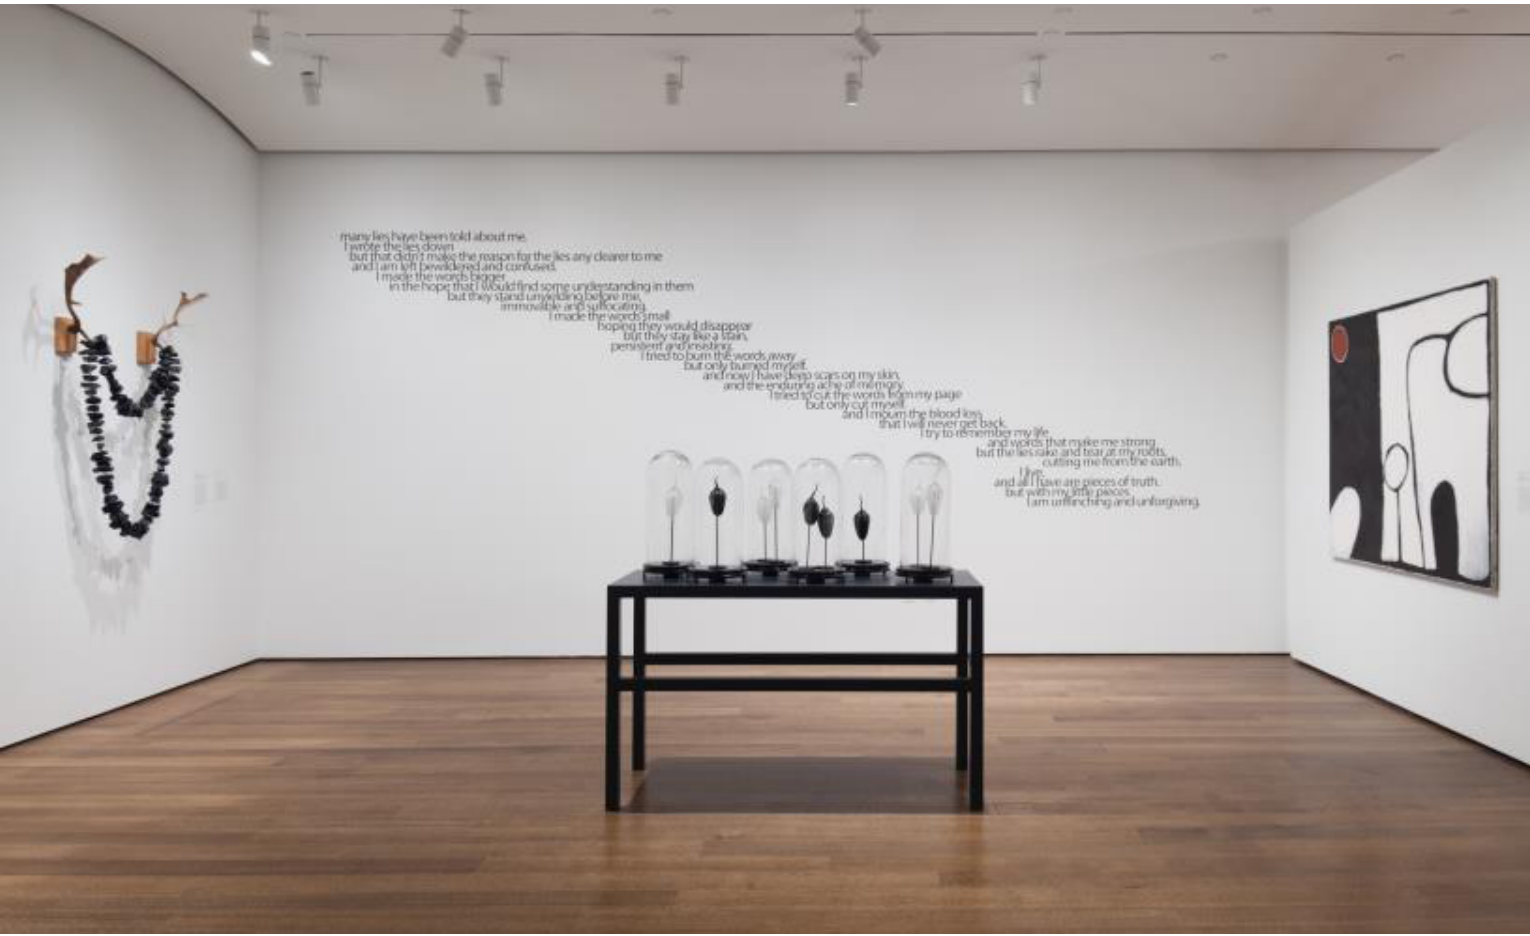
Installation view of “Remembrance” module from Everywhen: The Eternal Present in Indigenous Art from Australia, Harvard Art Museums, Cambridge, MA, curated by Stephen Gilchrist. Works left to right: Julie Gough, Dark Valley, Van Dieman’s Land , 2008; Vernon Ah Kee, many lies , 2004; Yhonnie Scarce, The silence of others (series of six) N2360, N2409, N2357, N2394, N1858, N2358 ; and Paddy Nyukuny Bedford, Emu Dreaming , 2003. Image Courtesy Harvard Art Museums, © President and Fellows of Harvard